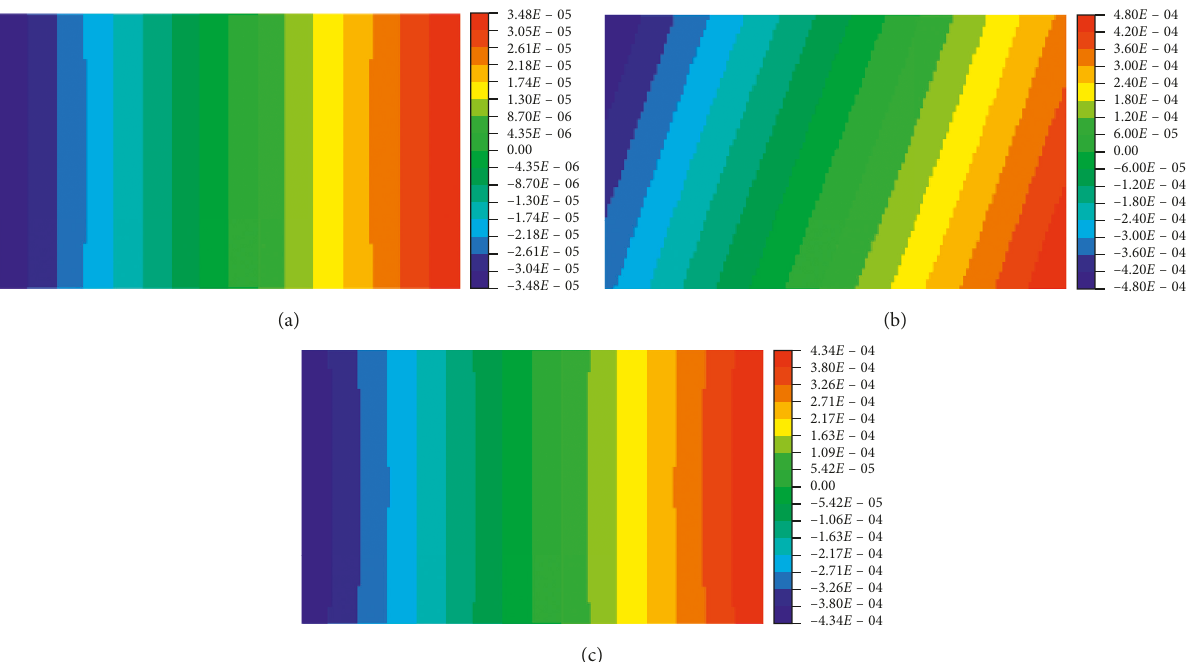
Figure 12: Horizontal displacement of UD reinforced lamina with different fiber directions. (a) α